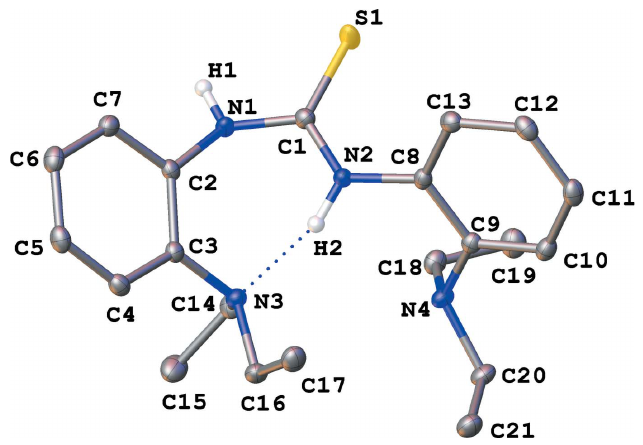
Figure 2 Molecular structure of 2 with displacement ellipsoids at the 50% probability level. Hydrogen atoms attached to carbon were omitted from the figure.